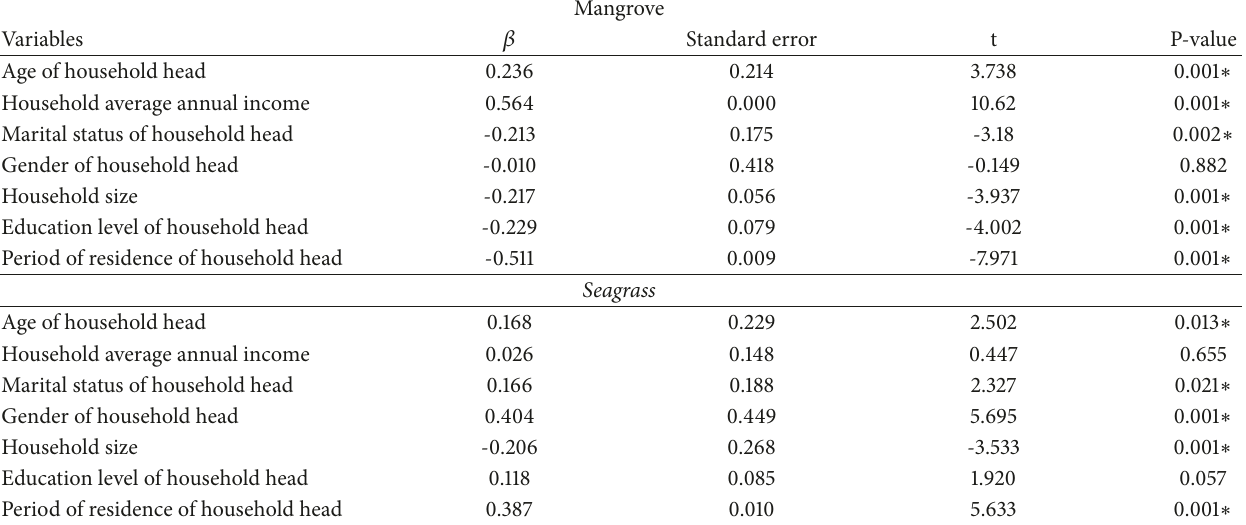
Table 4: Multiple regression analysis of socioeconomic factors influencing extraction of mangrove and seagrass resources in the study areas. Mangrove (n= 60, R 2 =0.614) and seagrass R 2 =0.562, ∗ =statistically significant at 0.05 level of significance